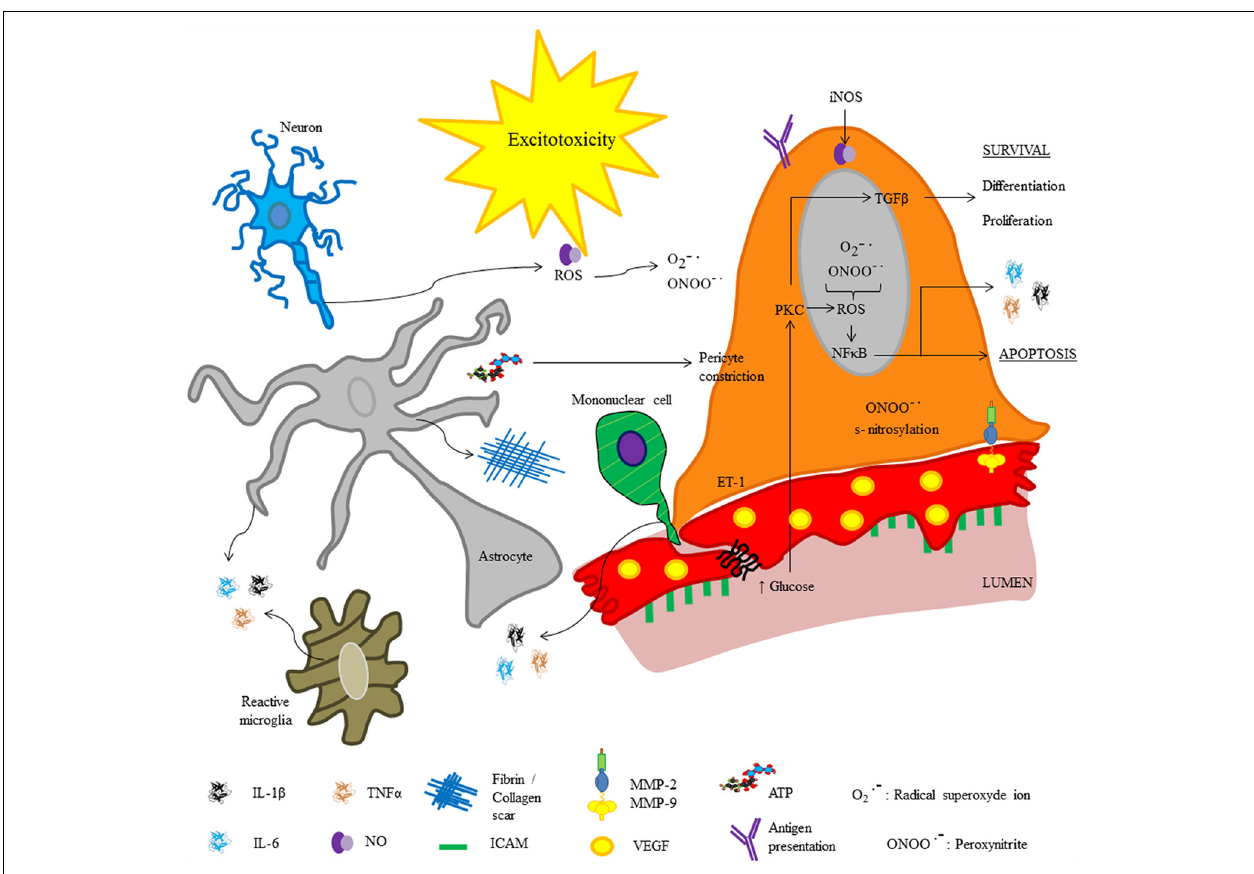
FIGURE 3 | Molecular inflammatory changes in brain pericytes in pathophysiological conditions. The cartoon depicts molecules released by pericytes under altered physiological conditions (e.g., neurodegeneration, infections or brain injury). Excitotoxicity may occur secondary to blood–brain barrier